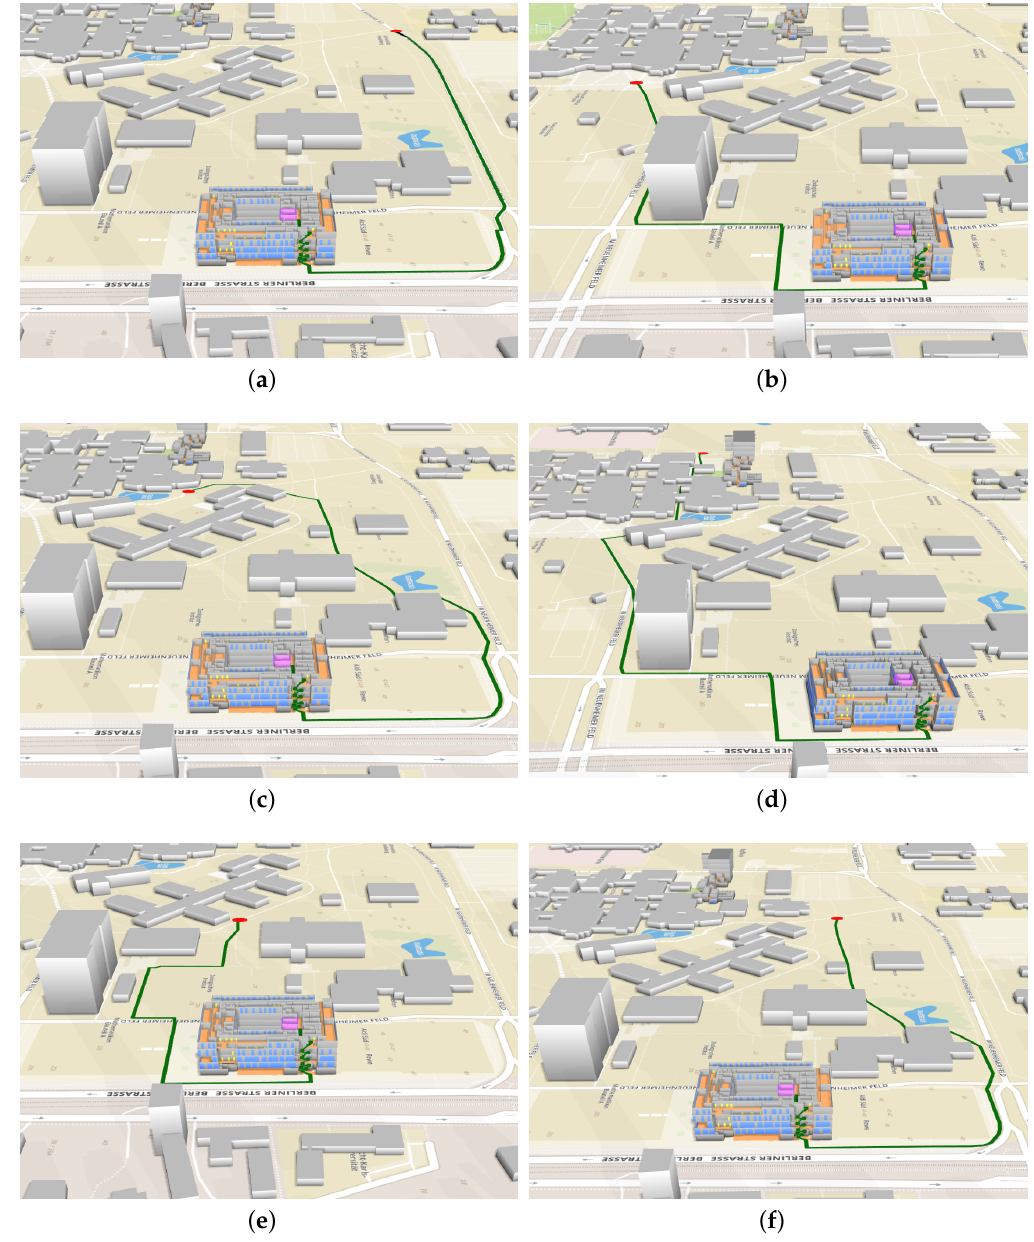
Figure 17. An overview of integrated indoor and outdoor routes (in green) from three outdoor points (in red) to a room (in purple) in the Mathematikon building. The windows and the doors of the buildings are colored in blue and in yellow, respectively. ( a ) Route R1; ( b ) Route R3 ( c ) Route R5; ( d ) Route R7; ( e ) Route R9; ( f ) Route